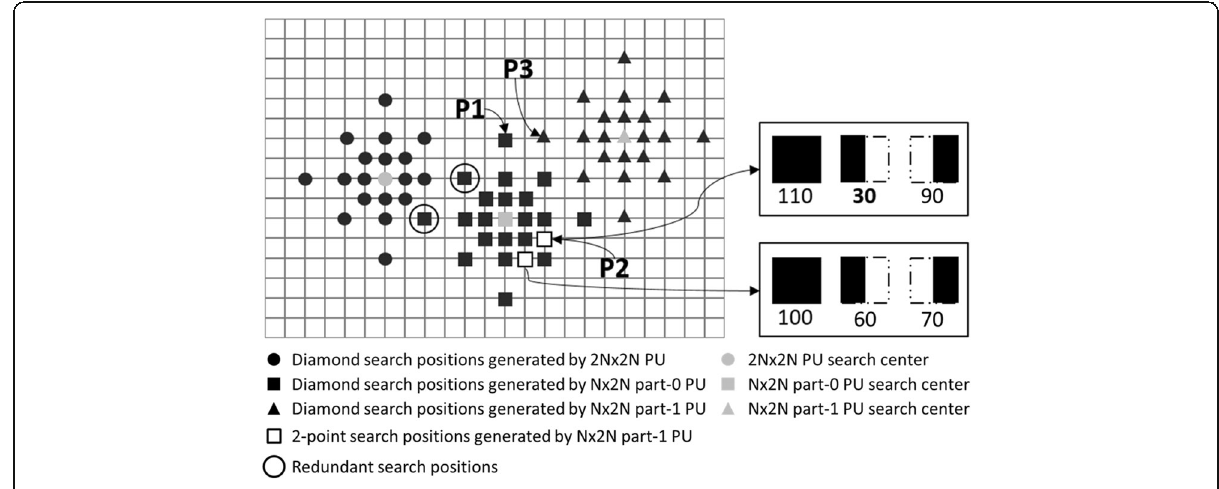
Fig. 5 The two-point search for the N × 2 N part-0